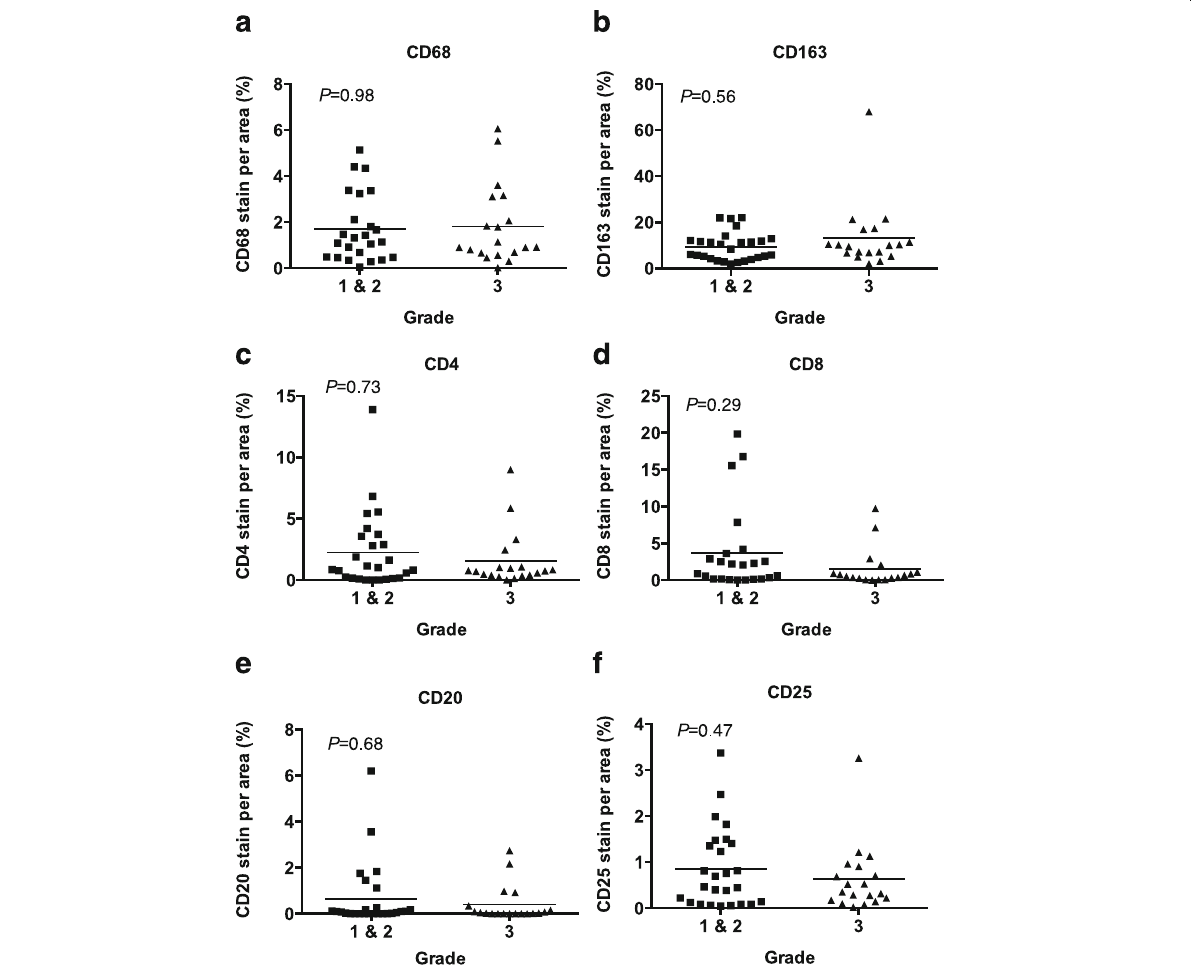
Fig. 3 The density of TILs does not differ between tumor grades in breast tumors from Kenya. Breast cancer tissue samples were stained for TILs, including CD68, CD163, CD4, CD8, CD20, and CD25. Each sample was scored for percentage of positively stained area for the indicated TIL. The positively stained areas then were compared across tumor grades 1 & 2 and 3 by Mann-Whitney CD68 a , CD163 b , CD4 c , CD8 d , CD20 e , and CD25 f ( P =0.98, 0.56, 0.73, 0.29, 0.68, and 0.47, respectively). The stained area did not significantly vary by